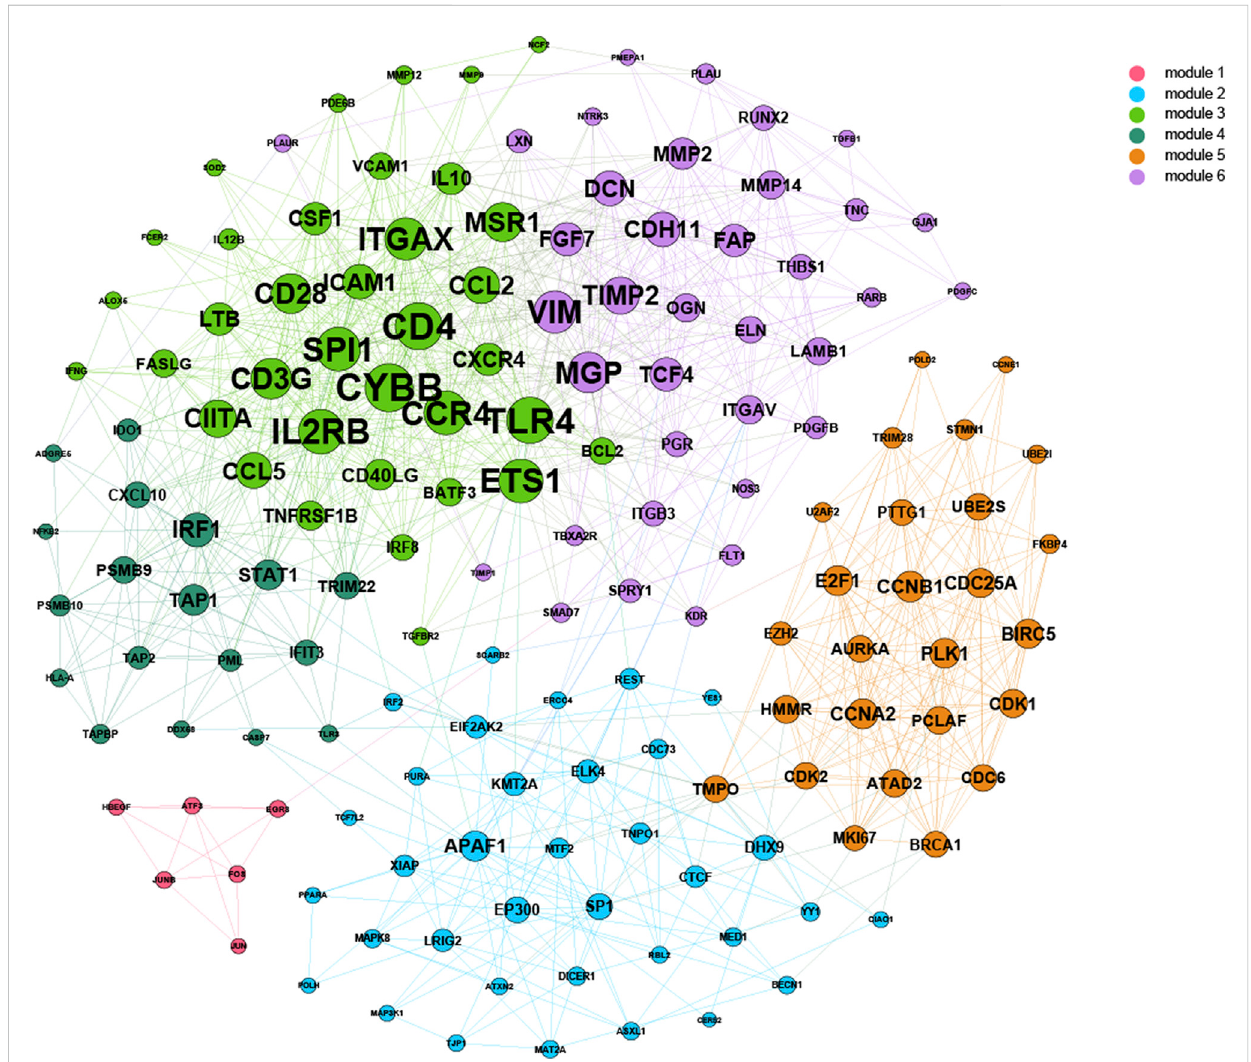
FIGURE 7 Construction of the combined TF-gene regulatory network. For each cancer, a regulatory network was constructed from the adjacent matrix. The top 10% of TF-gene interactions were considered signi fi cant and combined into one network.